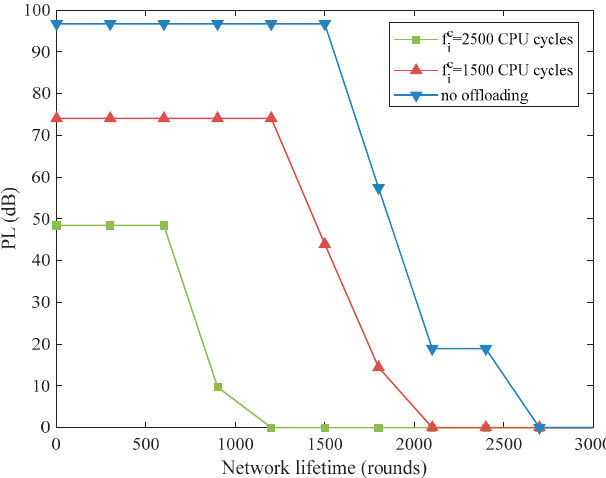
Figure 5. Path loss (PL) performance versus time under different scenarios.